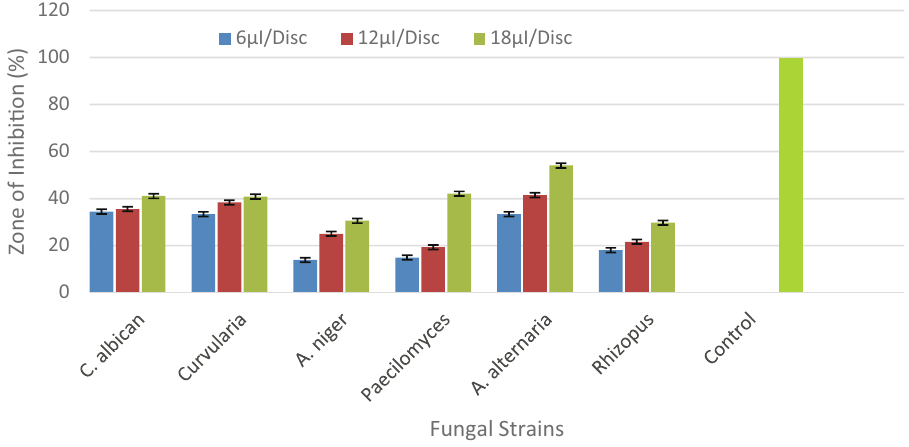
Figure 15: Antifungal activity with a standard deviation of AgNPs of pure ethanol extract of T. govanianum against di ff erent fungal